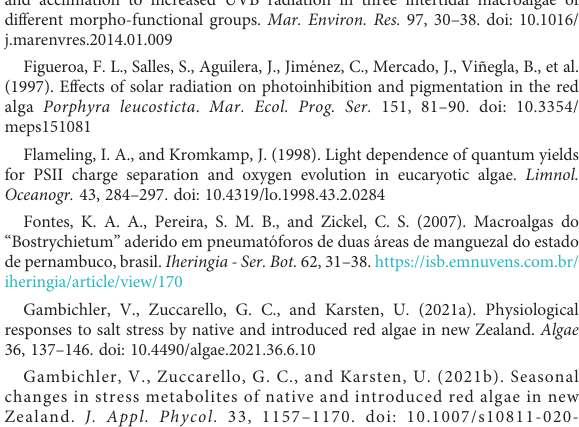
Figueroa, F. L., Dom ı ́ nguez-Gonza ́ lez, B., and Korbee, N. (2014). Vulnerability and acclimation to increased UVB radiation in three intertidal macroalgae